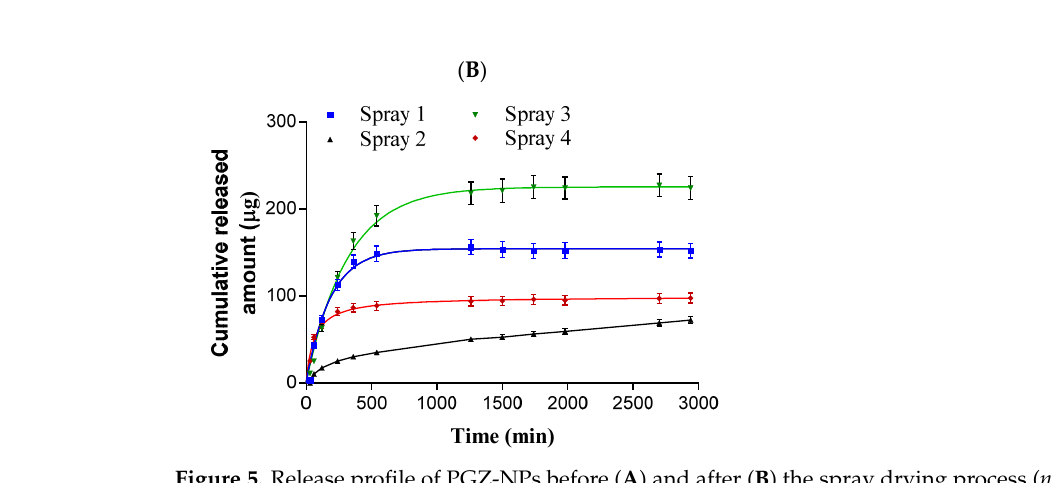
Figure 5. Release profile of PGZ-NPs before ( A ) and after ( B ) the spray drying process ( n = 6).